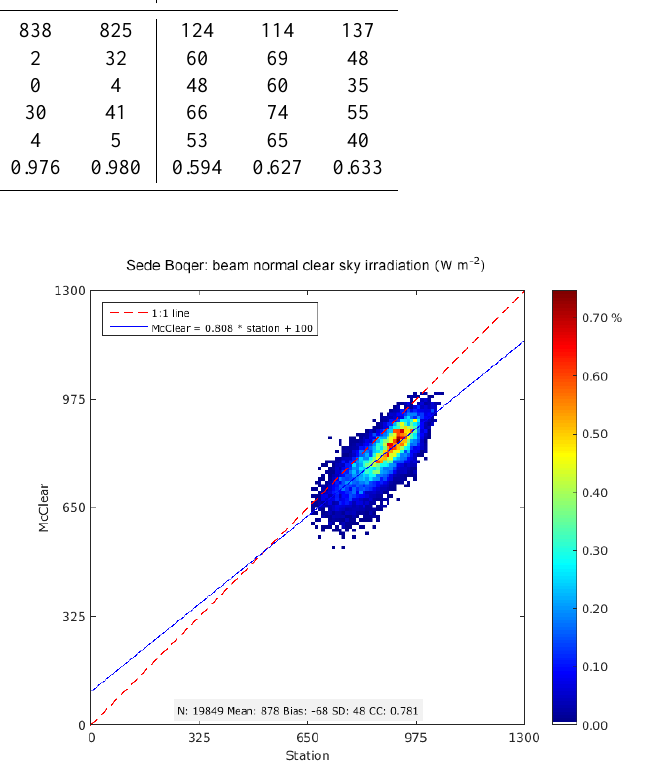
Figure 2. 2-D histogram of measurements (horizontal axis) and McClear estimates (vertical axis) of G for Sede Boqer. The colour represents the frequency of each pair.